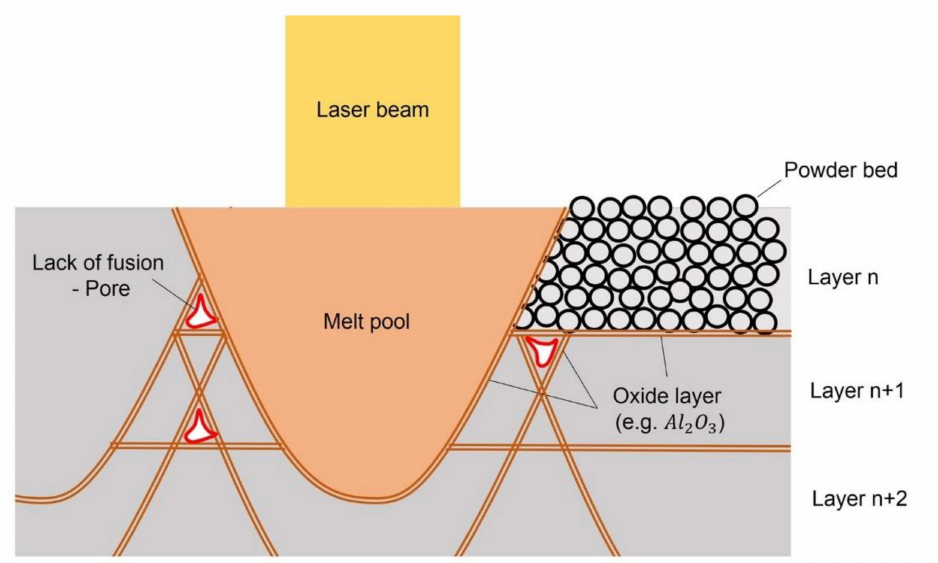
Figure 2. Formation of lack-of-fusion porosity due to the presence of oxide layers (inspired by Tang et al. [2] and Louvis et al.